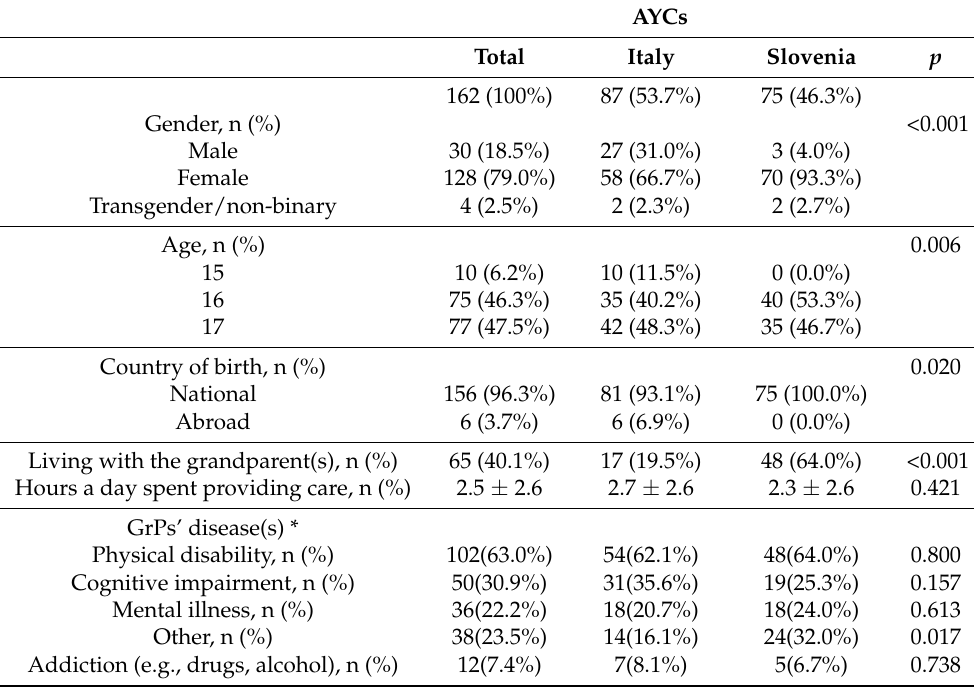
Table 1. Respondents’ characteristics by country and GrPs’